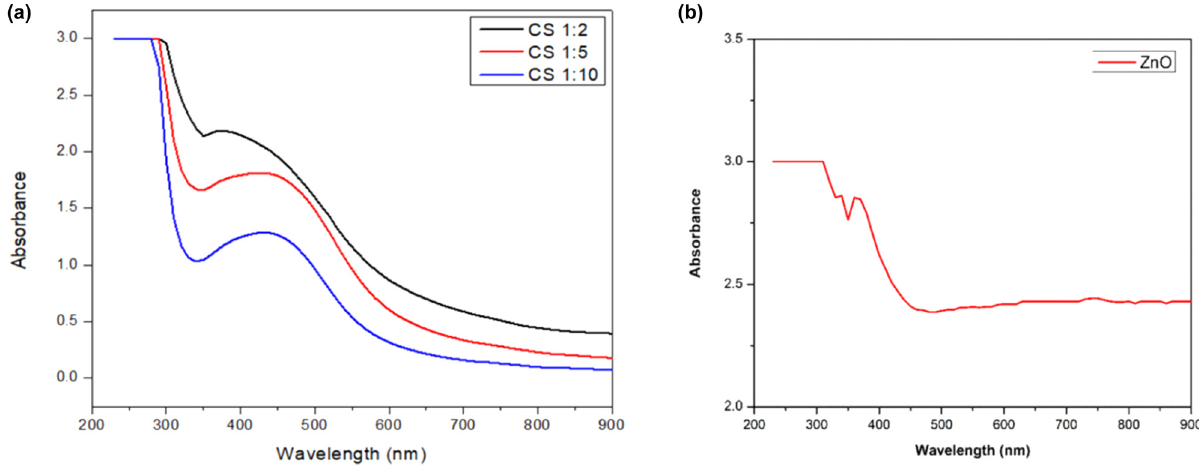
Figure 3: UV - Vis absorption spectra of ( a ) Ag - NPs and ( b ) ZnO